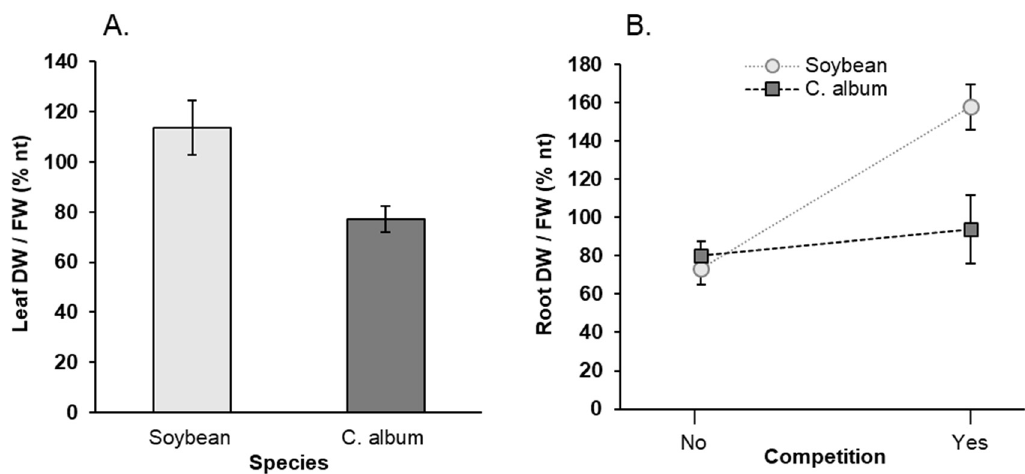
Figure 4. ( A ) Leaf dry weight (DW)/fresh weight (FW) ratios, expressed as percentage of salt-treated samples over nontreated samples (% nt). ( B ) Species-competition interaction for dry weight (DW)/fresh weight (FW) ratios of soybean and C. album roots (% nt). Values on the left refer to plants grown in single-species tanks (no competition). Values on the right refer to plants grown in mixed-species tanks (competition between soybean and C. album ). Vertical bars denote the standard error. The experiment was replicated twice, and only data from one representative experiment are shown.